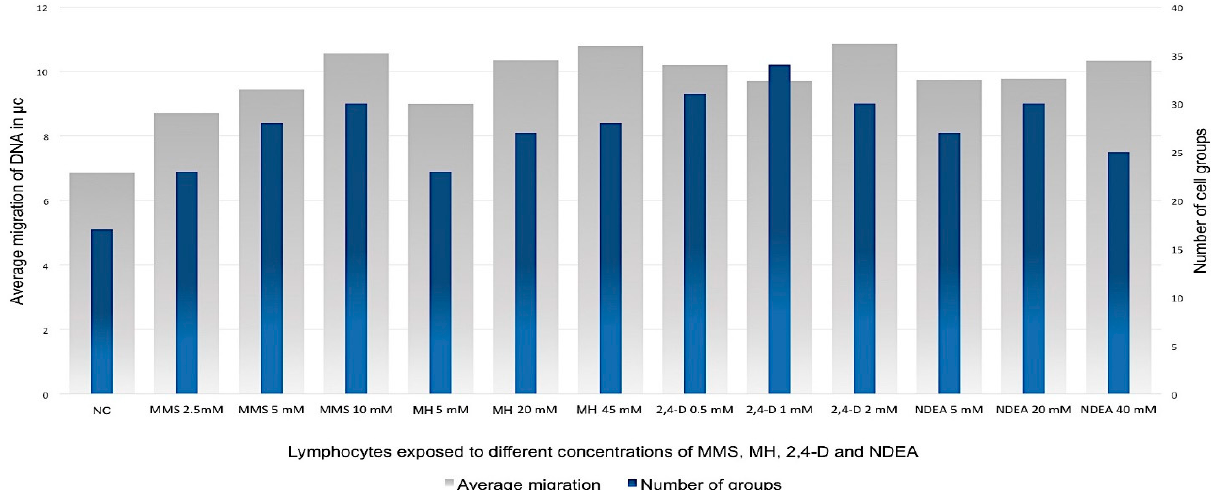
Figure 2. Average migration of DNA and number of migration groups observed in lymphocytes exposed to different concentrations of MMS, MH, 2,4-D, and NDEA. On the left, the average DNA migration is shown, and on the right side, the number of cells in each (comets) are indicated. Table 1. Migration groups and number of comets generated in each one caused by the exposure to MMS, MH, 2,4-D, and NDEA. The groups with the three largest numbers of comets (modes) are indicated in grey > blue > orange. Experimental